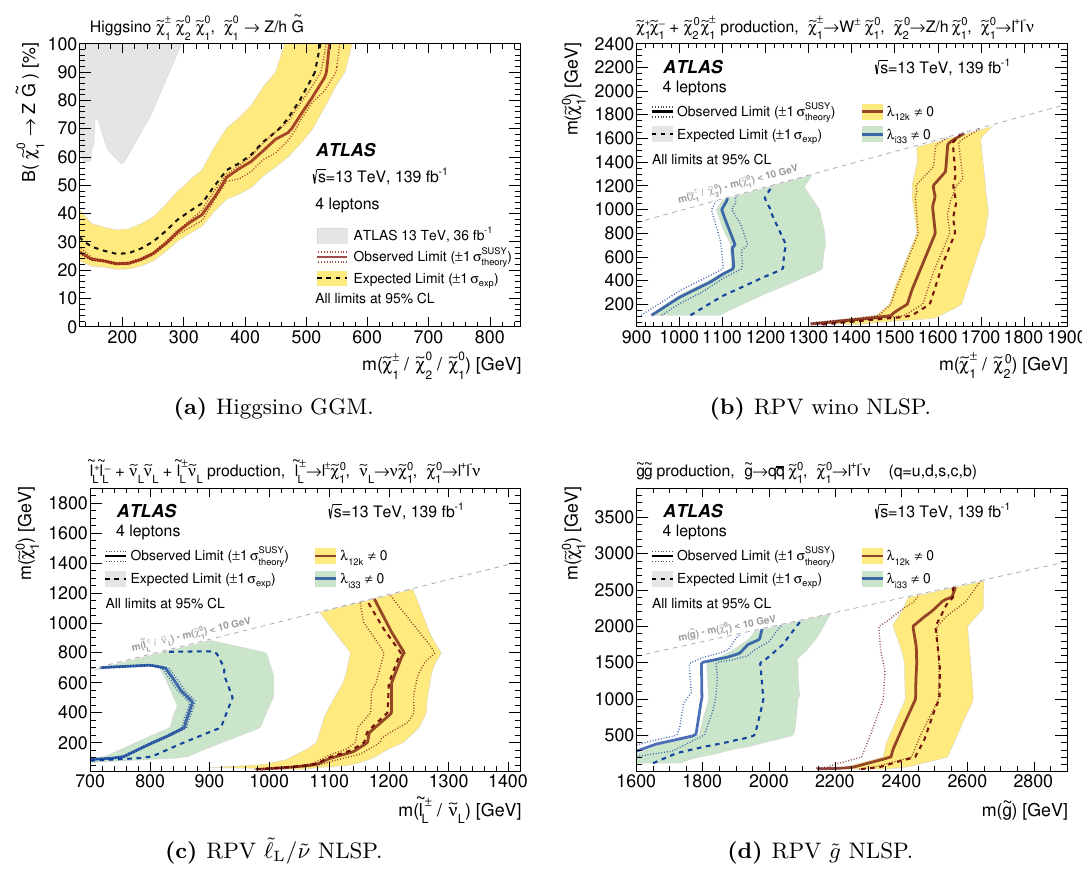
Figure 11. Expected (dashed) and observed (solid) 95% CL exclusion limits on (a) the higgsino GGM models, and (b) wino NLSP, (c) ˜ ‘ ˜ ν NLSP, and (d) gluino NLSP pair production with RPV L / ˜ χ 0 decays via λ , or λ where i, k ∈ 1 , 2 . The limits are set using a statistical combination of 1 12 k i 33 disjoint signal regions. Where two (or more) signal regions overlap, the signal region contributing its observed CL value to the combination is the one with the better (best) expected CL s